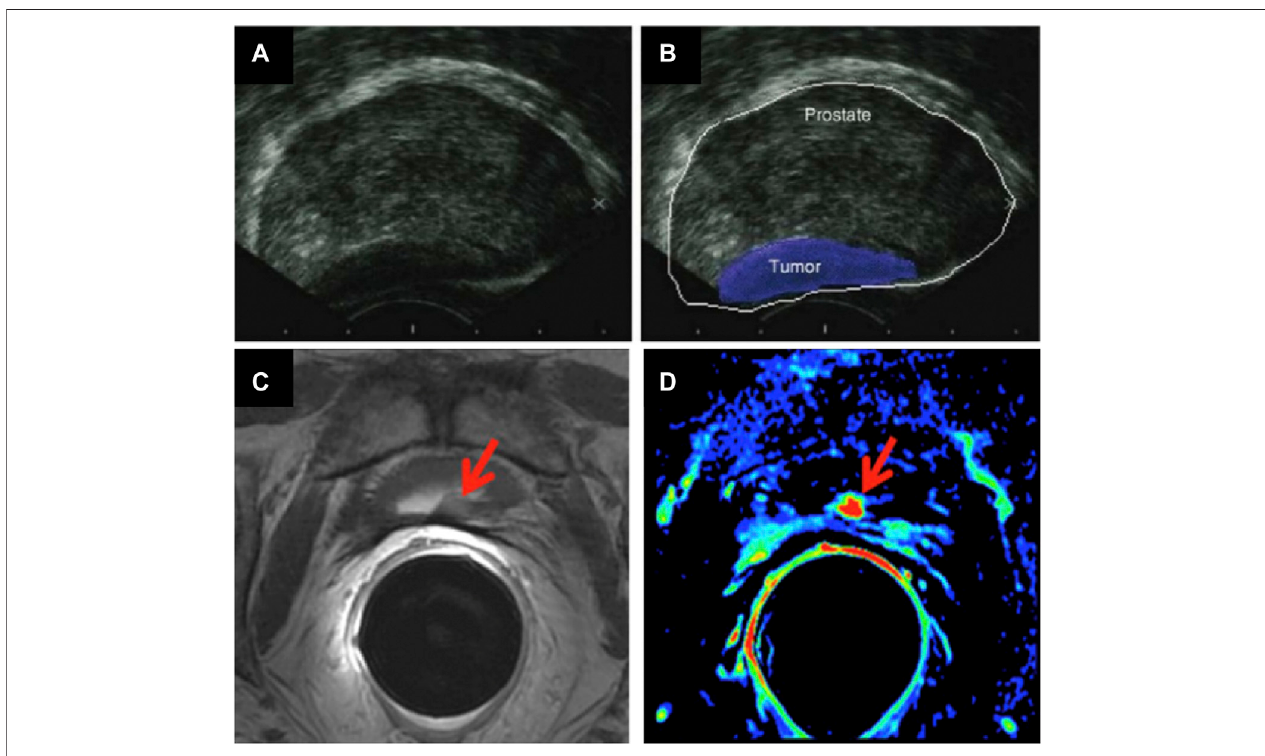
FIGURE 1 | (A,B) TRUS images of a prostate affected by cancer ( fi gure adapted from (Theodorescu and Ehdaie, 2009)); and MRI images of the prostate gland, showing cancerous regions (arrows): (C) Axial T2-weighted fast spin-echo image and (D) axial gradient-echo T1-weighted colour map image ( fi gure adapted from (Maurer et al.,